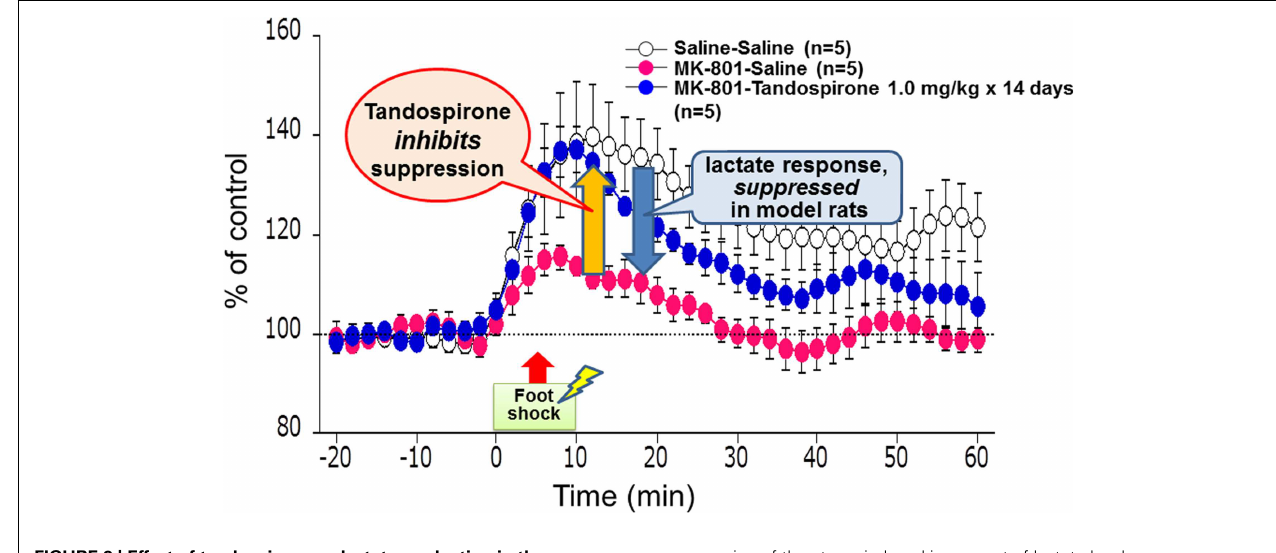
FIGURE 8 | Effect of tandospirone on lactate production in the prefrontal cortex of a rat model of schizophrenia, as measured by in vivo microdialysis . At the neonatal stage, rats were transiently injected with MK-801, an antagonist at the N -methyl- D -aspartate receptor, on postnatal days 7–10.These model animals showed